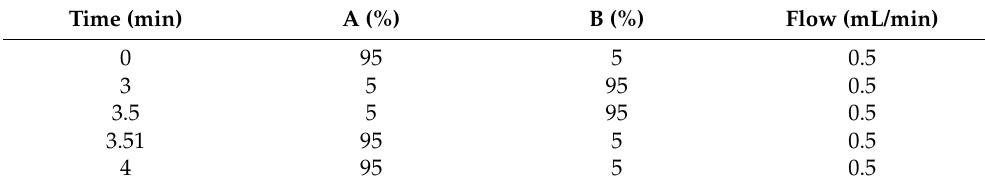
Table 2. Binary pump program used for linear gradient elution with mobile phases A and B. Time